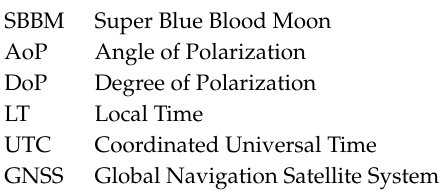
Table S1: Degree of Polarization (DoP) during the Super Blue Blood Moon (SBBM), Table S2: Angle of Polarization (AoP) during the Super Blue Blood Moon (SBBM), Table S3: Degree of Polarization (DoP) on 1 February 2018, Table S4: Angle of Polarization (AoP) on 1 February